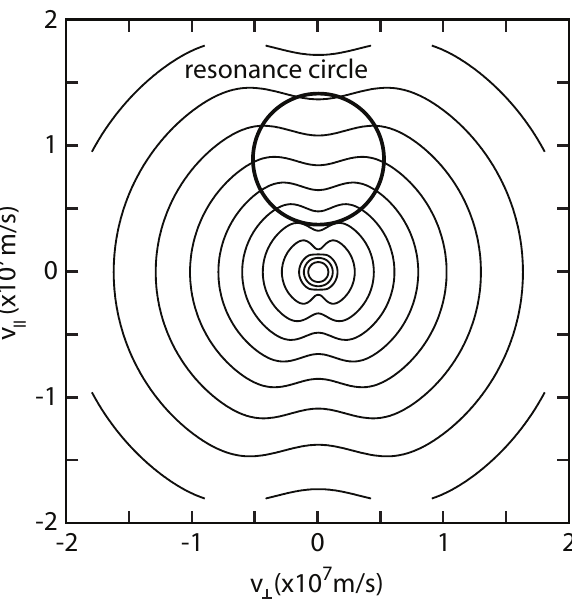
Fig. 7. Example of resonance circle for the case of ω p / (cid:127) =4, ω / (cid:127) =4.123, and θ =89.5 ◦